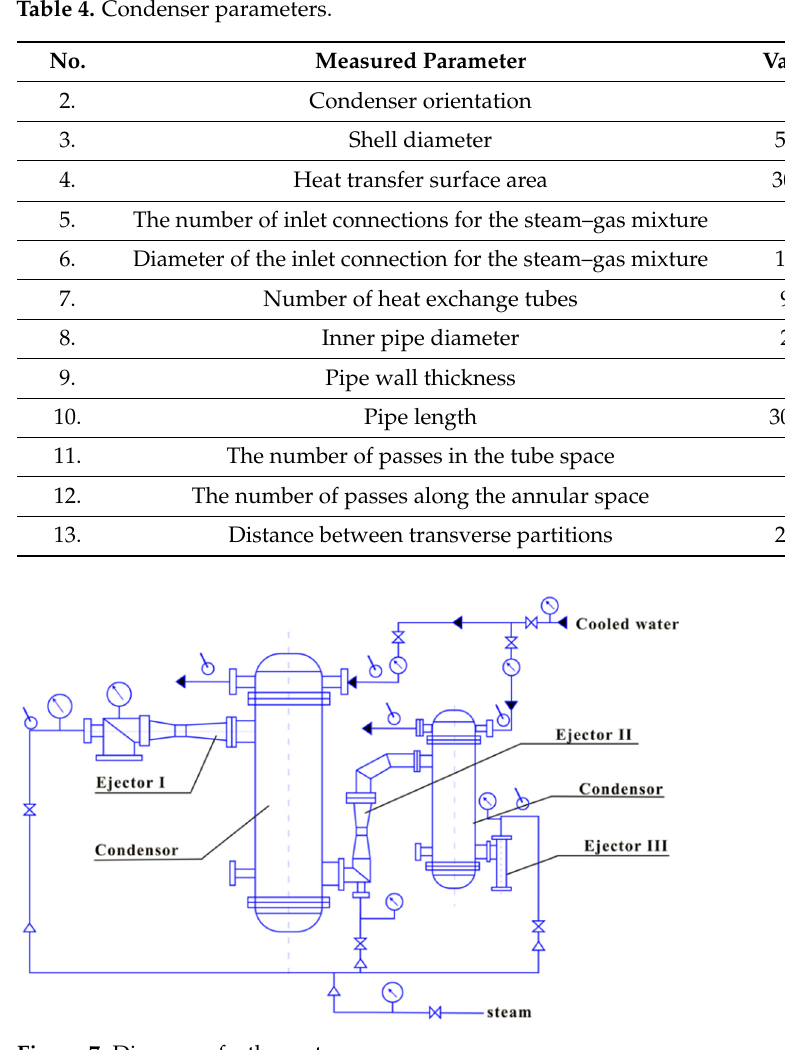
Figure 7. Diagram of a three-stage vacuum pump.